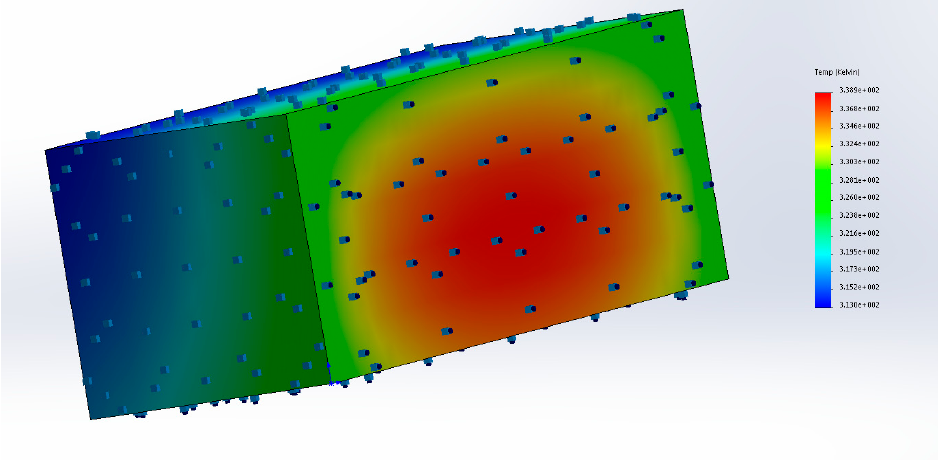
Figure 56. Alteration of the Thermal Loading for Steady-state Heating Cycle.